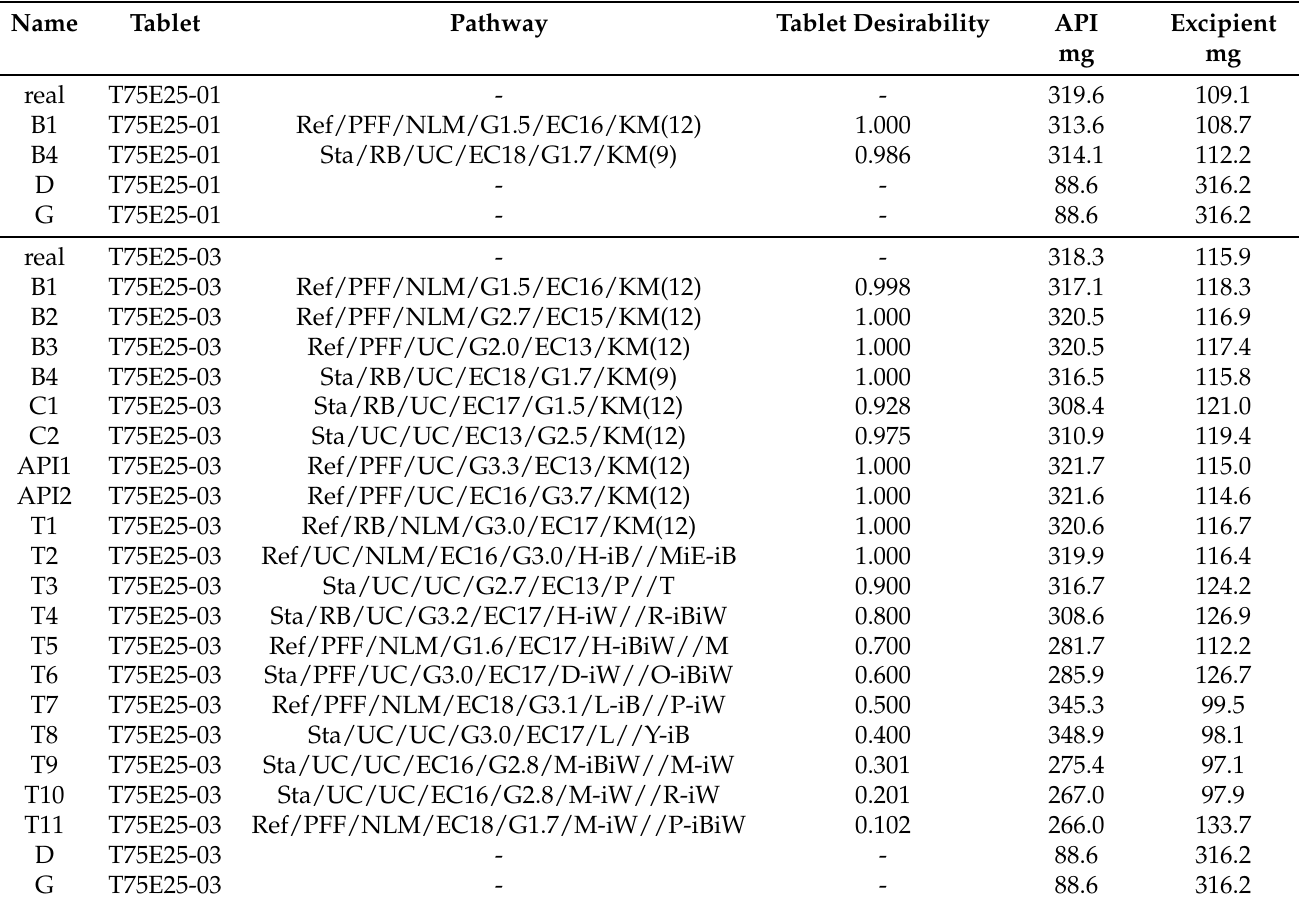
Table A2. The selected images for the in silico calculations. The line called real displays the determined real data of the